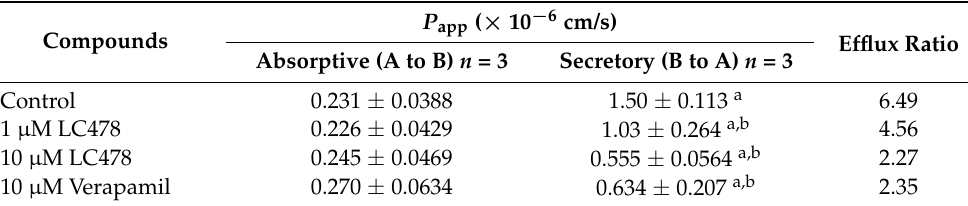
Table 1. Absorptive P app , secretory P app , efflux ratio of rhodamine-123 in Caco-2 cells with various concentrations of LC478 or verapamil.